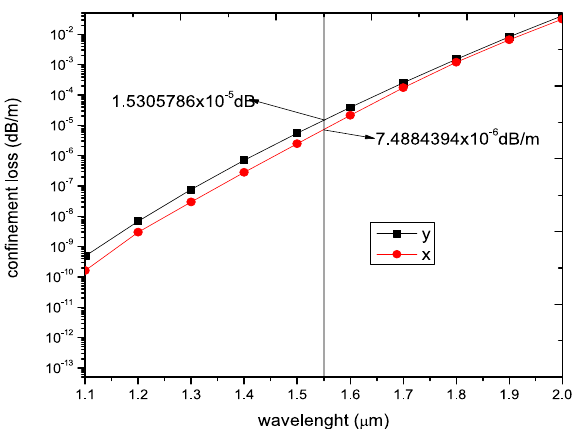
Fig. 6 C loss as a function of wavelength Λ